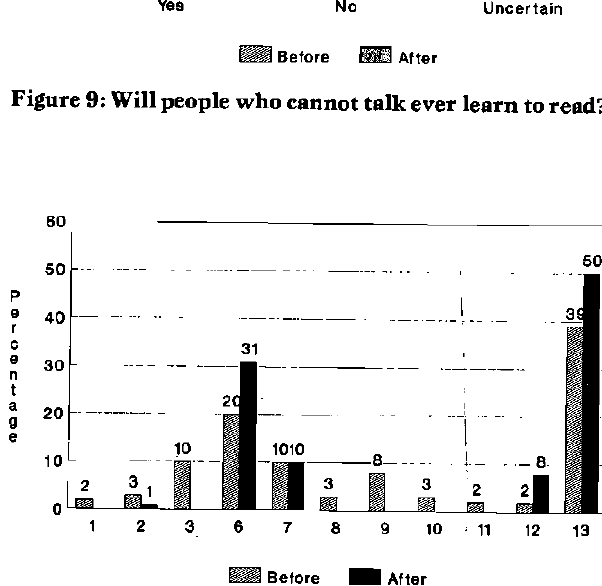
Figure 6: Respondents' special training received